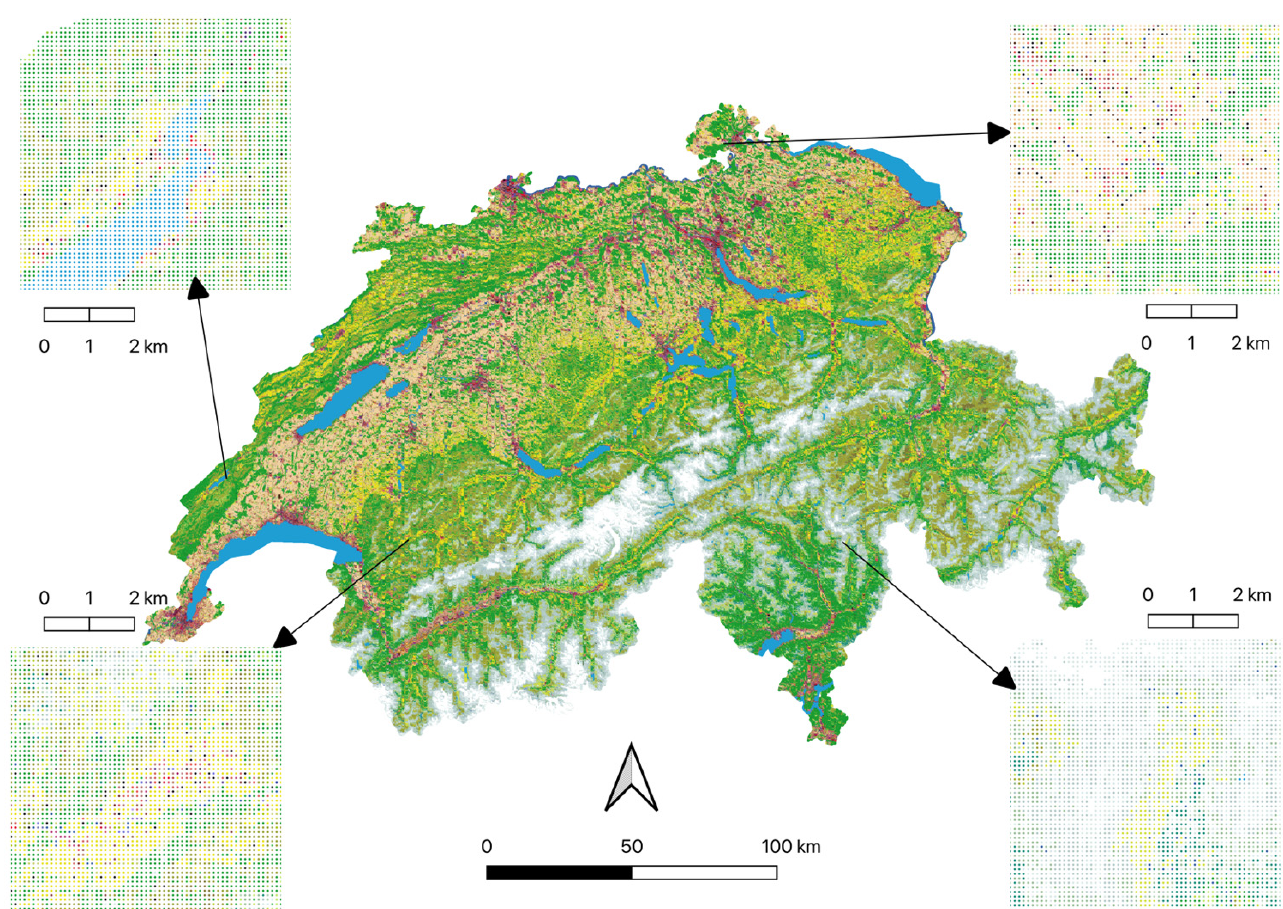
Figure 1. Original LU/LC statistics with 72 classes (Arealstatistik) at a 100 m resolution from the 2013–2018 period.